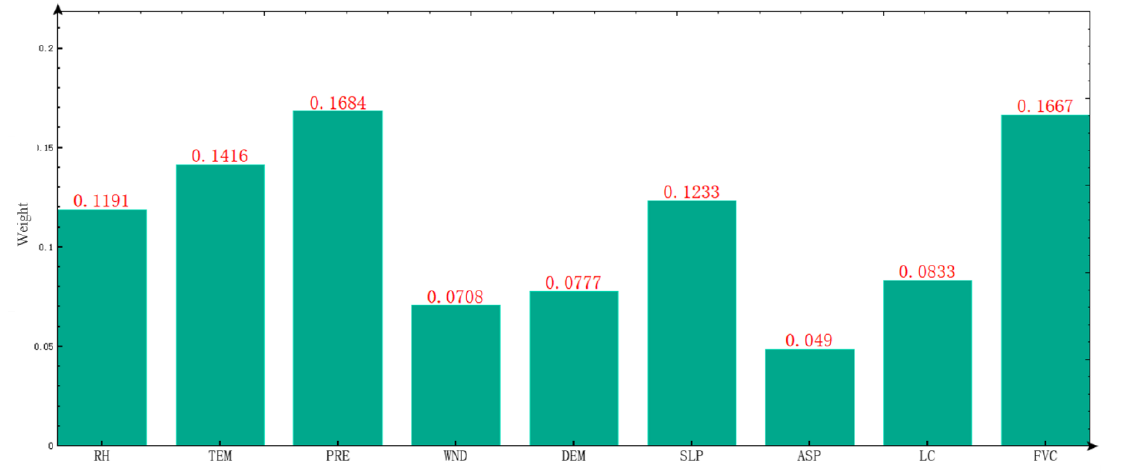
Figure 5 . Experimental result by AHP.